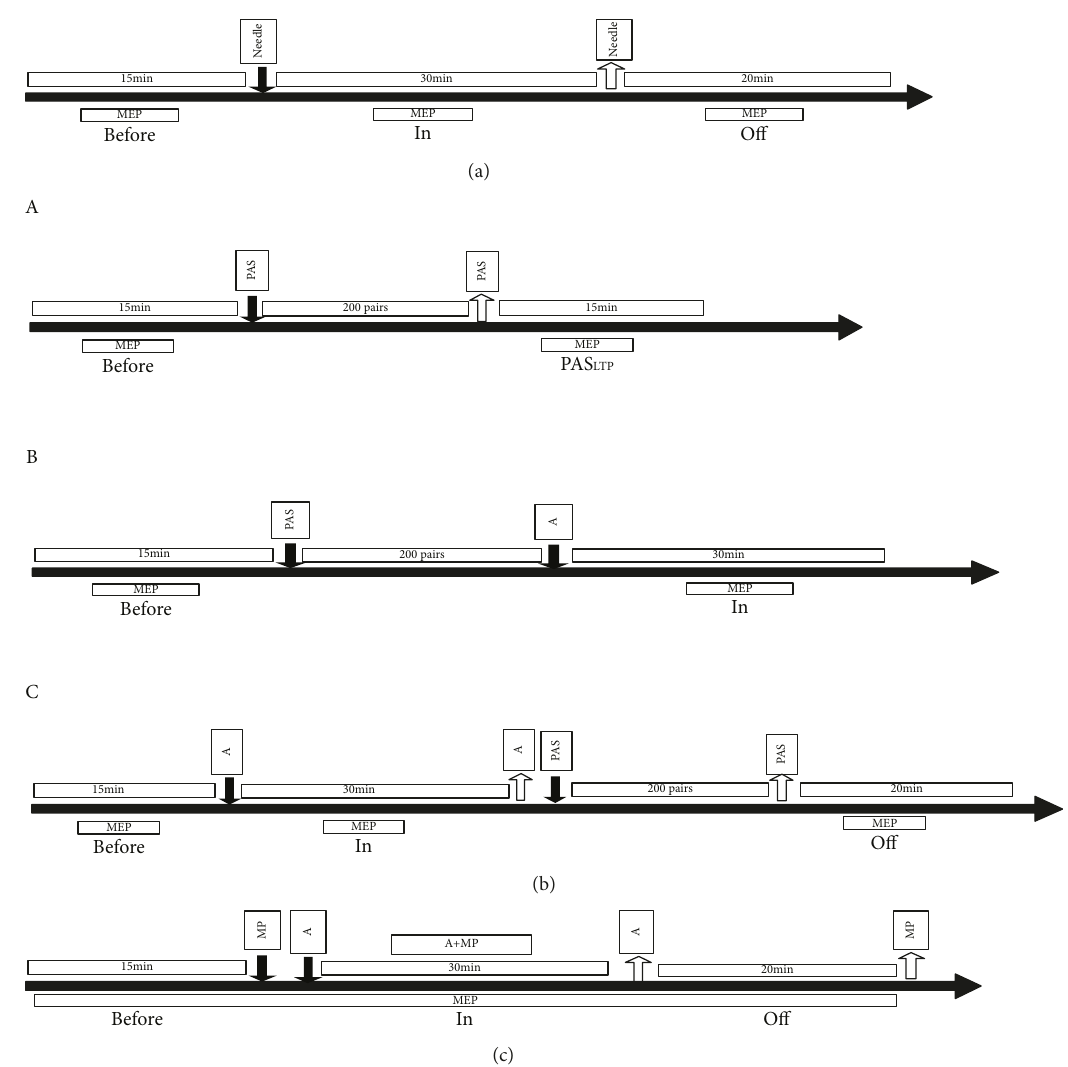
Figure 1: Experimental design. (a) MEP amplitudes induced by TMS over the bilateral M1 in resting conditions were measured at the “ Before ” (15 min before acupuncture), “ In ” (30 min with the needle in situ), and “ O ff ” (30 min after the needle removal) phases, at 30-second intervals; (b) the LTP-like plasticity induced by PAS was explored, TMS-MEP amplitudes over the bilateral M1 in resting conditions were measured at the “ Before ” (A), “ In ” (B), and “ O ff ” (C) phases; and (c) MP was tested. The average of MEP amplitudes (bilateral) were assessed at time points Before, MP (motor practice), A (acupuncture with in situ), A+MP (acupuncture+motor practice), and O ff by normalization to the